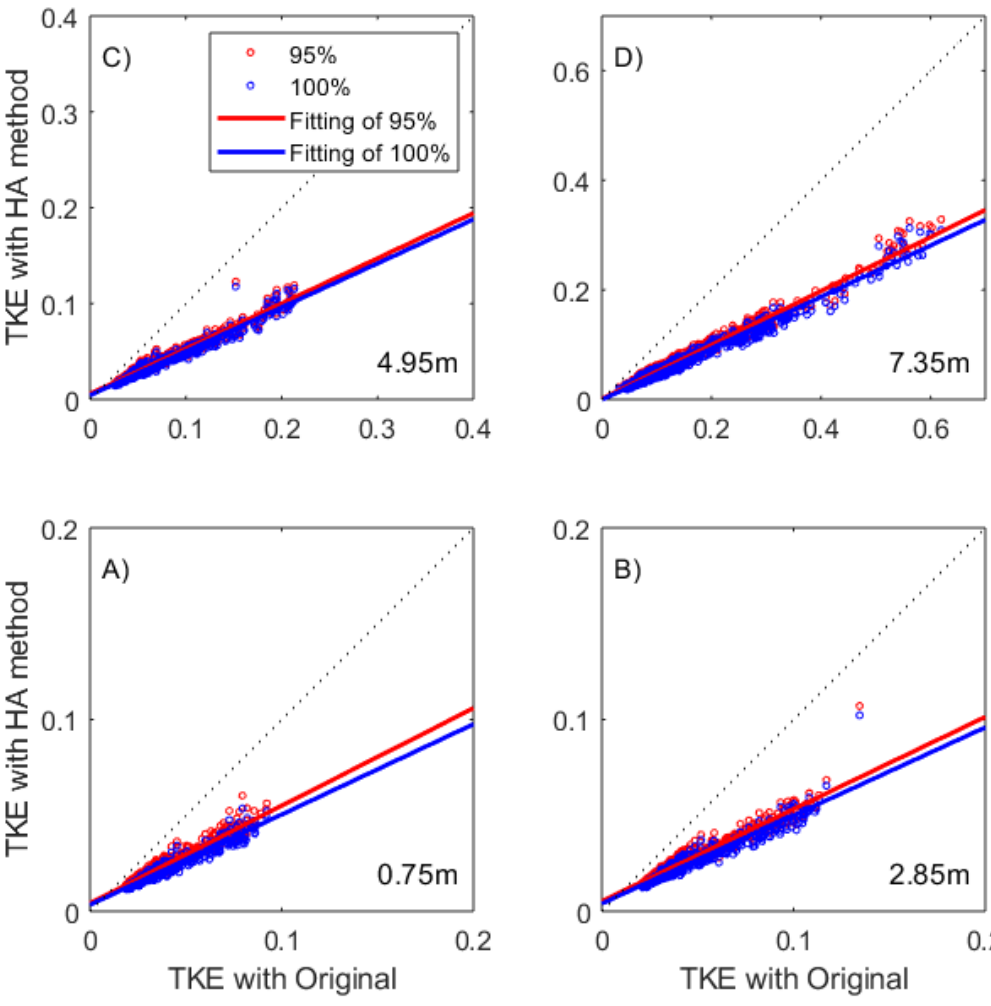
Figure 11. Comparison of TKE with original data to TKE with the HA method ( A ) at 0.75 m, ( B ) at 2.85 m, ( C ) at 4.95 m, and ( D ) at 7.35 m. Red and blue circles denote the estimation of 95% and 100% wave-removed data, respectively. Red and blue solid lines denote the corresponding linear-fitting line of the estimations. Black dotted line indicates the reference line of equilibrium between TKE with original data and TKE with the HA method.